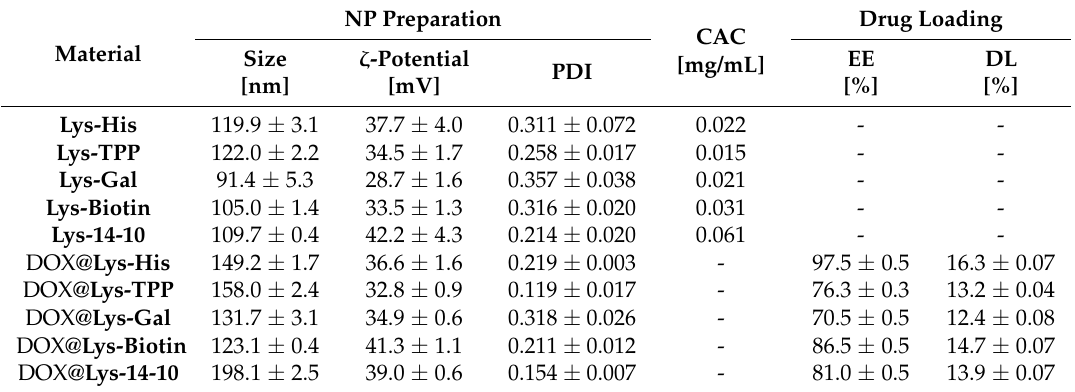
Table 1. Characterization of drug-free and drug-loaded bolaamphiphiles nanoparticles